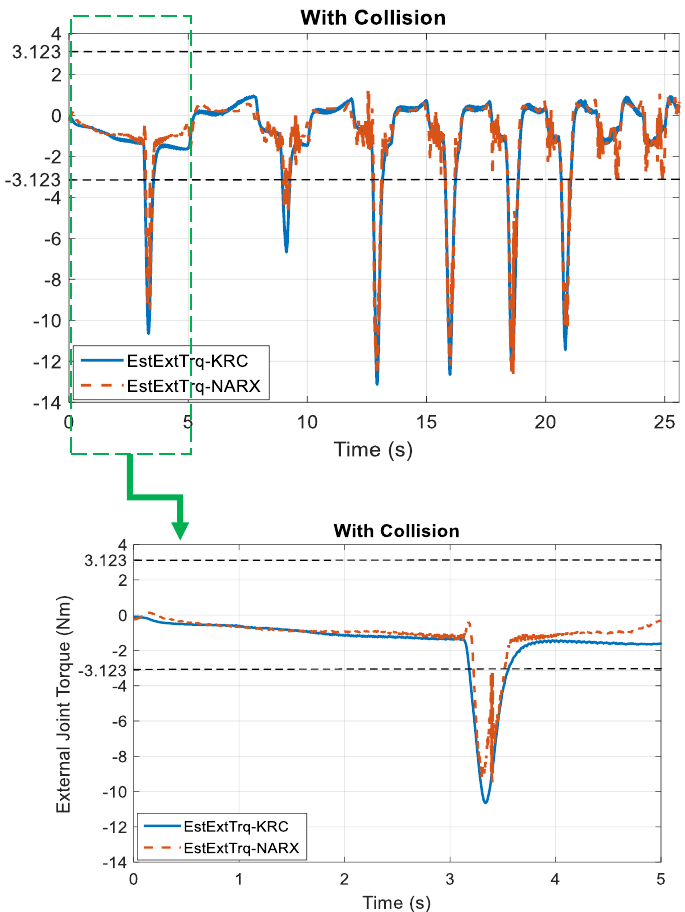
Figure 9. The estimated external joint torque of the NARXNN is compared by the provided torque by KRC, in the case of no collision. The effectiveness (%) and the evaluation of the presented NARXNN using different data from the training data are presented in the next section.